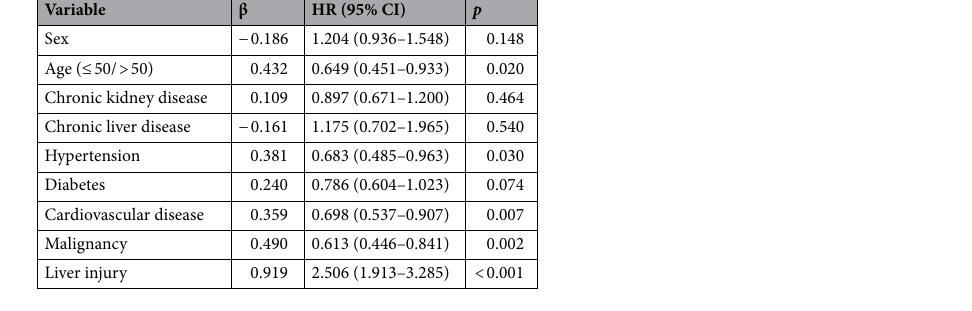
Table 2. Multivariable Cox regression for clinical outcomes in COVID-19